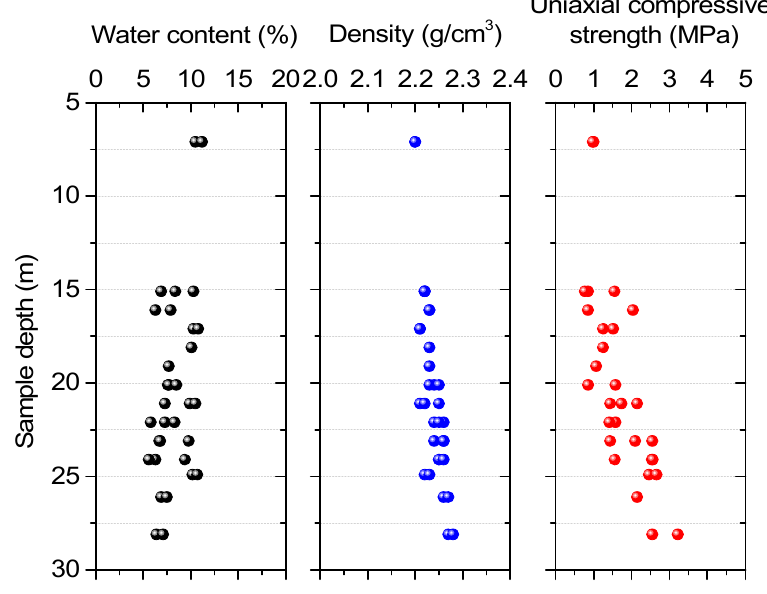
Figure 3. Variations of properties of mudstone with sample depth determined from laboratory.